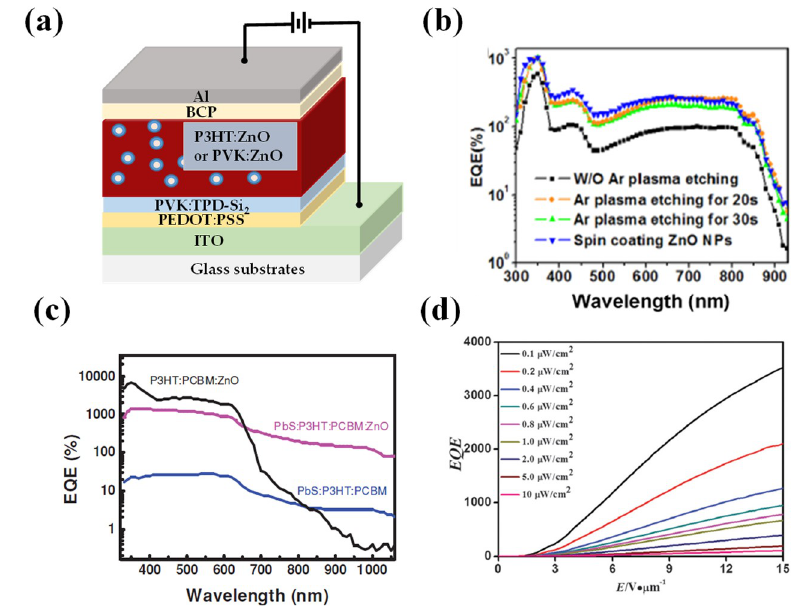
Figure 5. Device performances of various polymer PM photodetectors based on bulk heterojunctions with inorganic materials and insulating polymers. ( a ) Structural diagram of ITO/PEDOT:PSS/PVK:TPD‐Si 2 /P3HT:ZnO (PVK:ZnO)/BCP/Al device; ( b ) EQE spectra of the PDTP‐ DFBT based PM photodetectors blended with ZnO nanoparticles treated by different processes (Reproduced with permission from [76]. AIP Publishing 2015); ( c ) EQE spectra of the